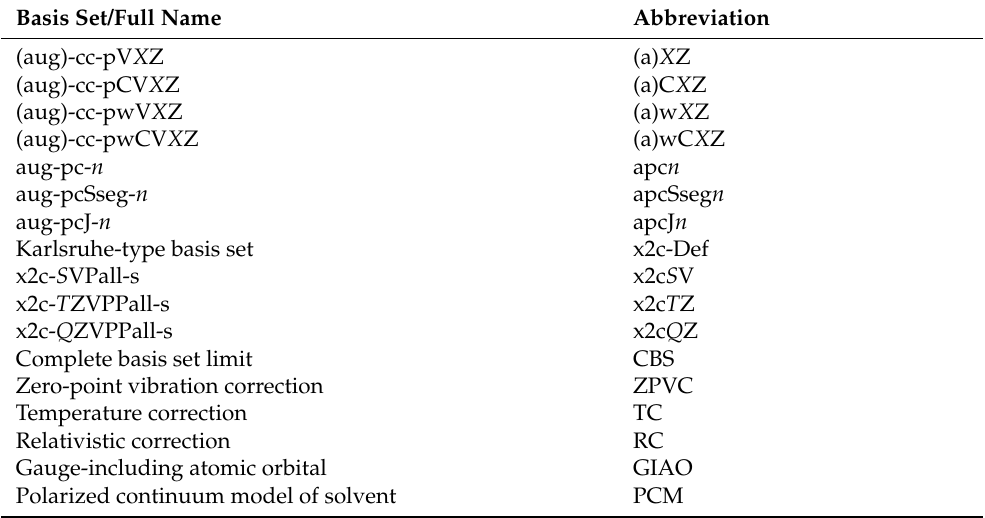
Table 1. List of applied basis sets and their